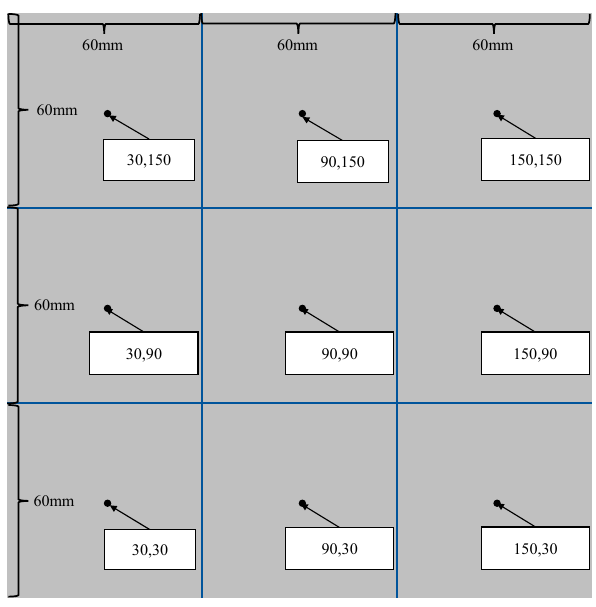
Figure 5. Schematic diagram of aluminum plate.